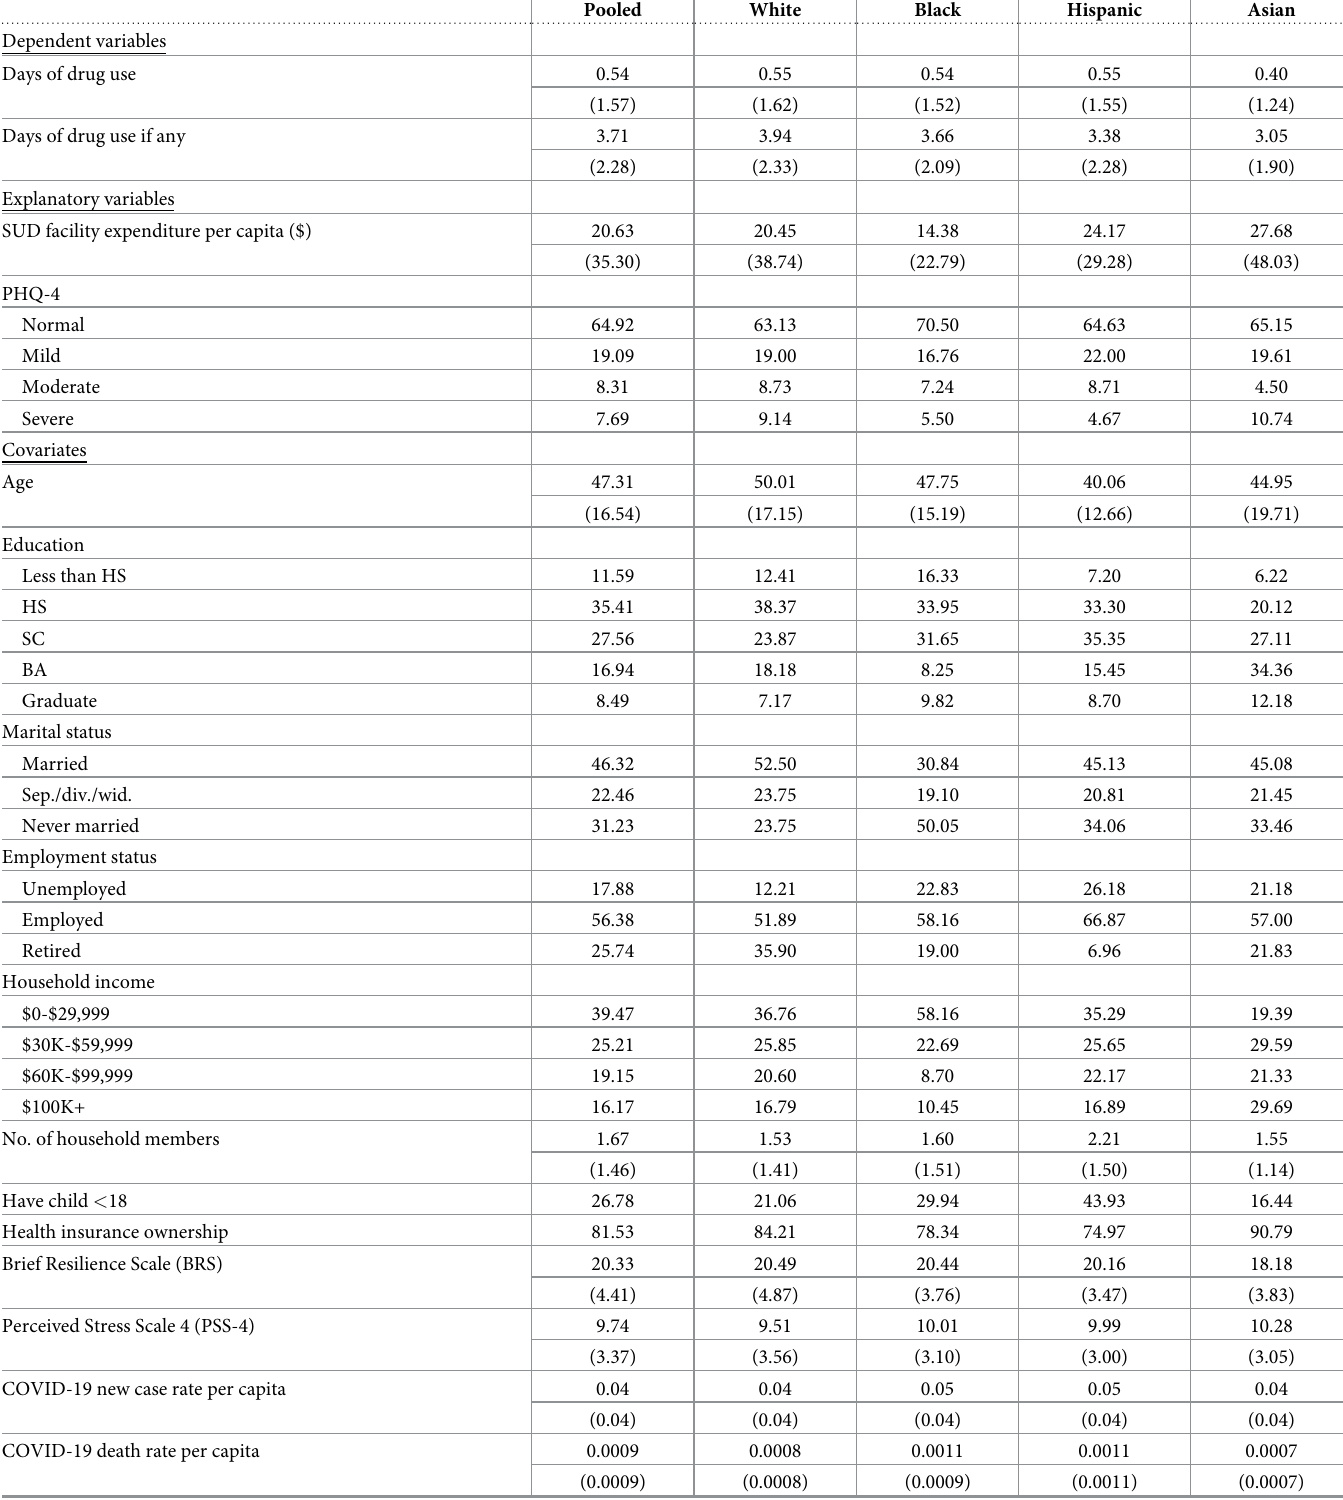
Table 1. Sample characteristics.